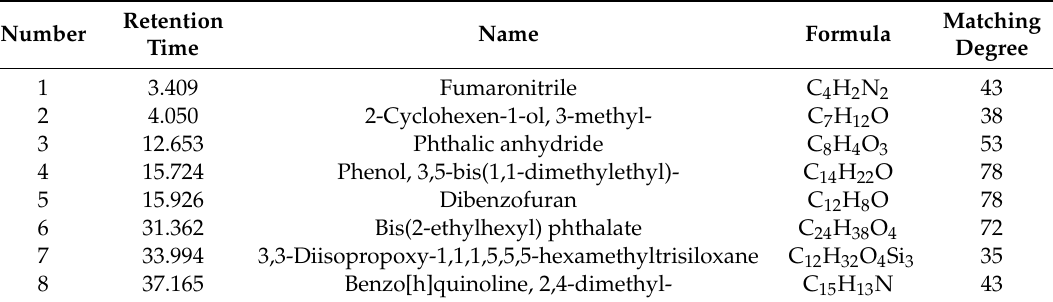
Table 5. Exhaust components absorbed by activated carbon in